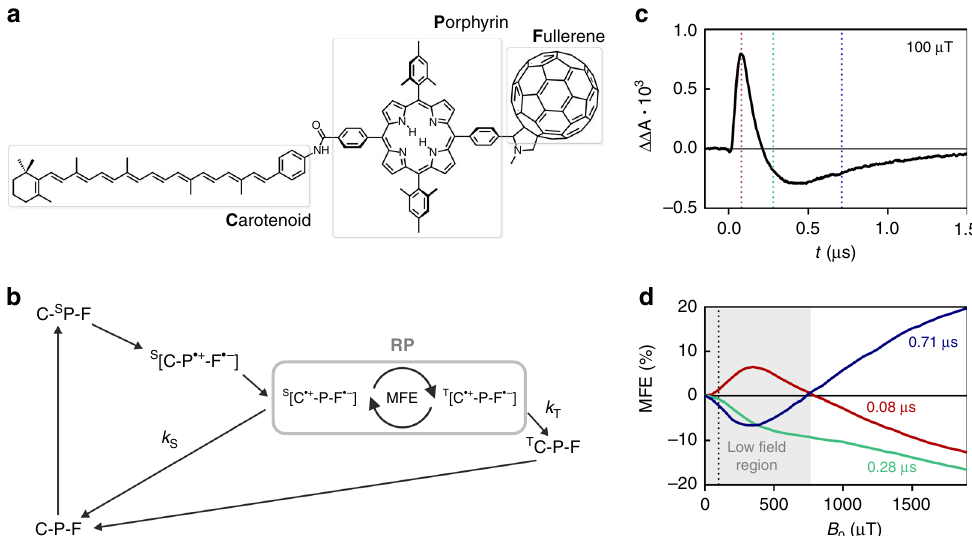
Fig. 1 Chemical structure, photocycle, and time dependence of the magnetic fi eld effect (MFE) of CPF . a Structure of the molecular CPF triad. b Simpli fi ed photoscheme including all processes of relevance for this study. For simplicity, the secondary radical pair C (cid:129) + - P - F (cid:129) − is shown as created in a pure singlet state. For more detailed photochemical information, refer to refs. 40,41 . c Transient absorption subtraction signal ΔΔ A of the radical pair, probed at 980 nm, obtained upon application of a magnetic fi eld of B 0 = 100 μ T. The dotted lines in red, green, and blue indicate delay times of 0.08, 0.28, and 0.71 μ s after laser excitation, respectively. d Magnetic fi eld dependence of the MFE averaged for a time window of 20 ns centred around the indicated delay times. The dotted black line indicates the fi eld position of 100 μ T and the fi eld region approximately corresponding to the low fi eld region is highlighted in